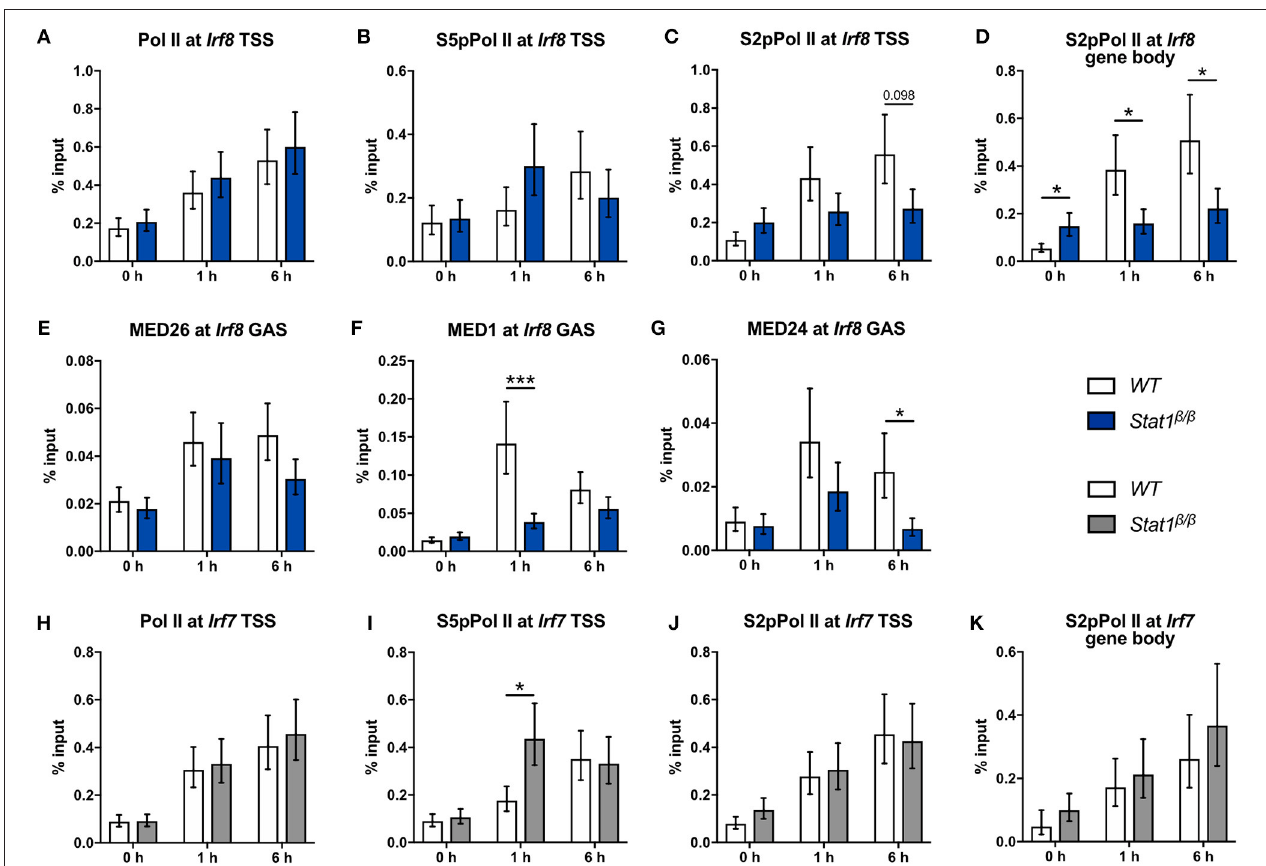
FIGURE 7 | Recruitment and phosphorylation of Pol II at the Irf8 and Irf7 genes and occupancy of Mediator components at the Irf8 promoter. (A–K) BMDMs from WT and Stat1 β/β mice were stimulated with IFN γ for the times indicated or left untreated (0h). Association of Pol II, S5pPol II, and S2pPol II with the Irf8 (A–C) and the Irf7 promoters (H–J) around the TSS and of S2pPol II within the respective gene bodies (D,K) was determined by ChIP. The promoter occupancy of MED26 (E) , MED1 (F), and MED24 (G) at the Irf8 GAS. Data were normalized to the input control. Mean values ± SE from two (K) , three (A–I) or four (J) independent experiments are shown; * P ≤ 0.05 , ** P ≤ 0.01 , *** P ≤ 0.001